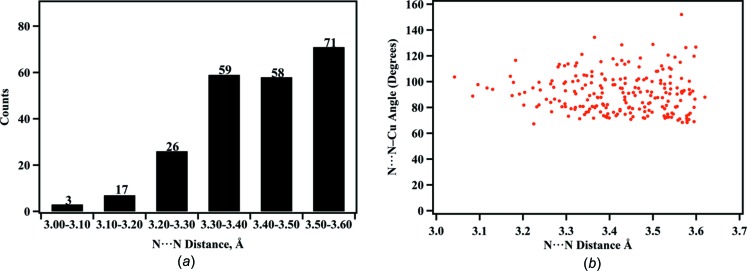
Histograms of N—H⋯Cu—C≡N—Cu contacts (a) and angles (b).